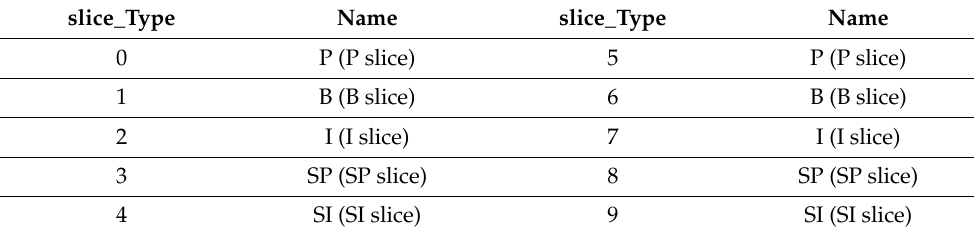
Table 2. H.264 slice type.